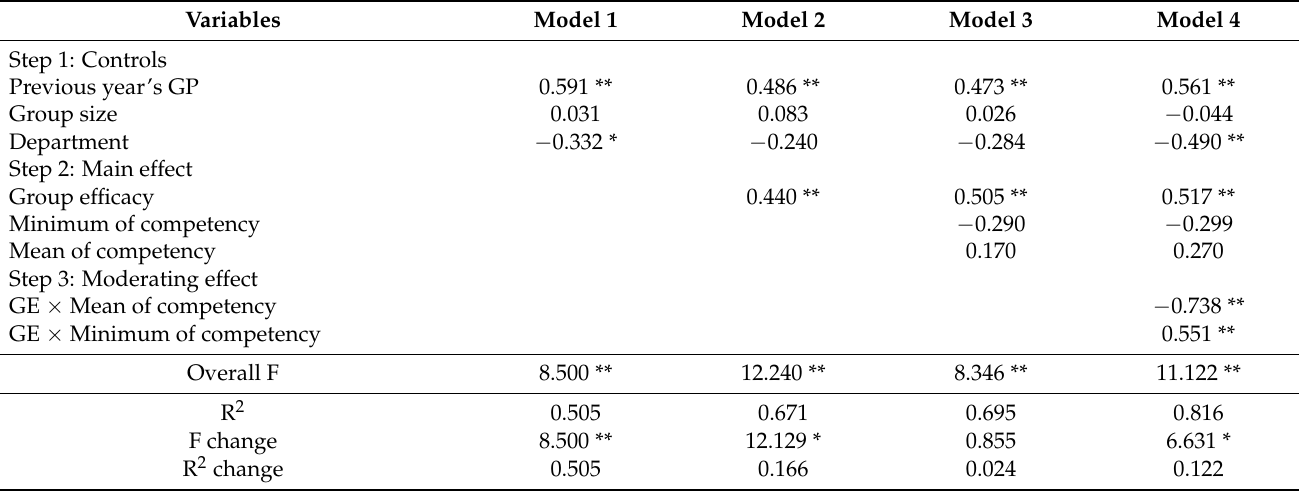
Table 3. Results of the Relationship between Group Efficacy, Competency, and Member-Rated Group Performance.